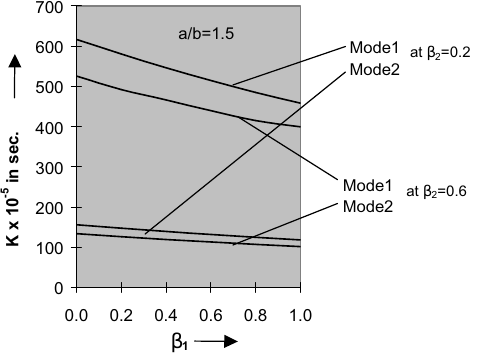
Fig. 2. Time period K vs taper constant β 1 of a clamped visco-elastic rectangular